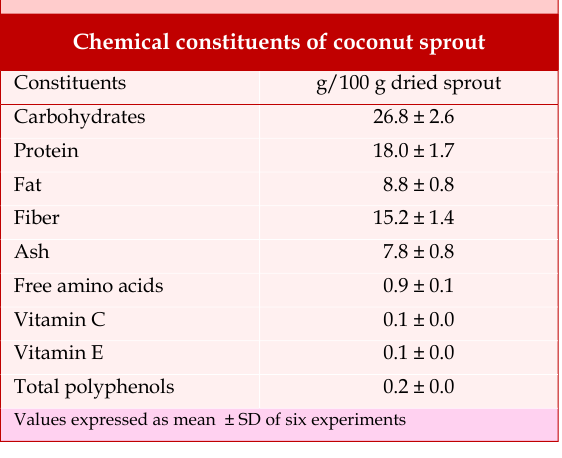
marker enzymes in serum of sprout fed normal rats (Group III) was similar to that of normal control rats.